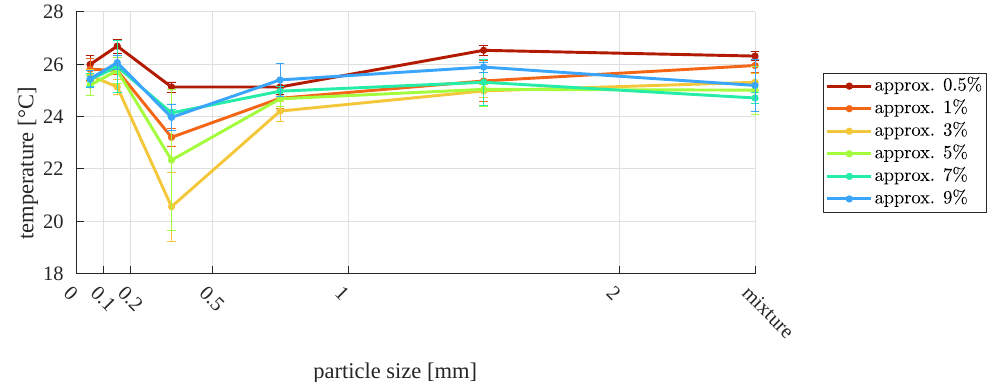
Figure 14. Surface temperature as function of particle size, for different relative moistures—first approach (macro images).